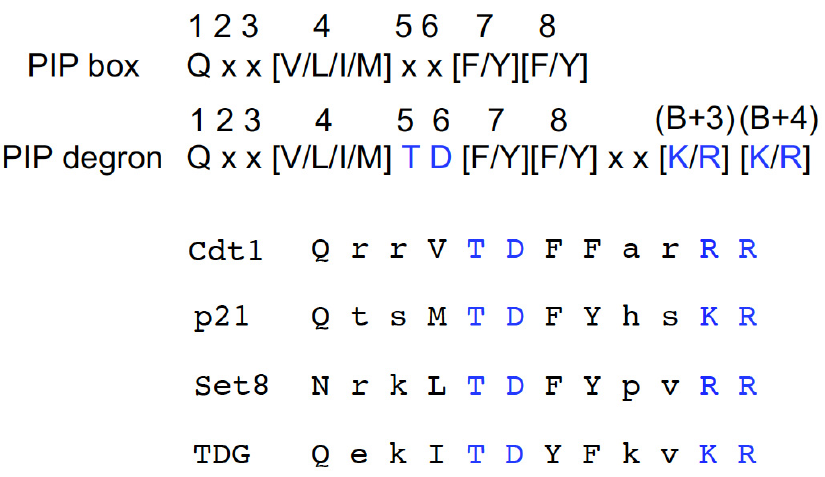
Figure 3. PIP box and PIP degron amino acid sequences. The TD motif (threonine and aspartate residues) at the fifth and sixth positions and the basic amino acids [K/R] at the third and fourth positions downstream of the PIP box are crucial for substrate recognition and degradation. The PIP degrons found in representative substrates are listed.